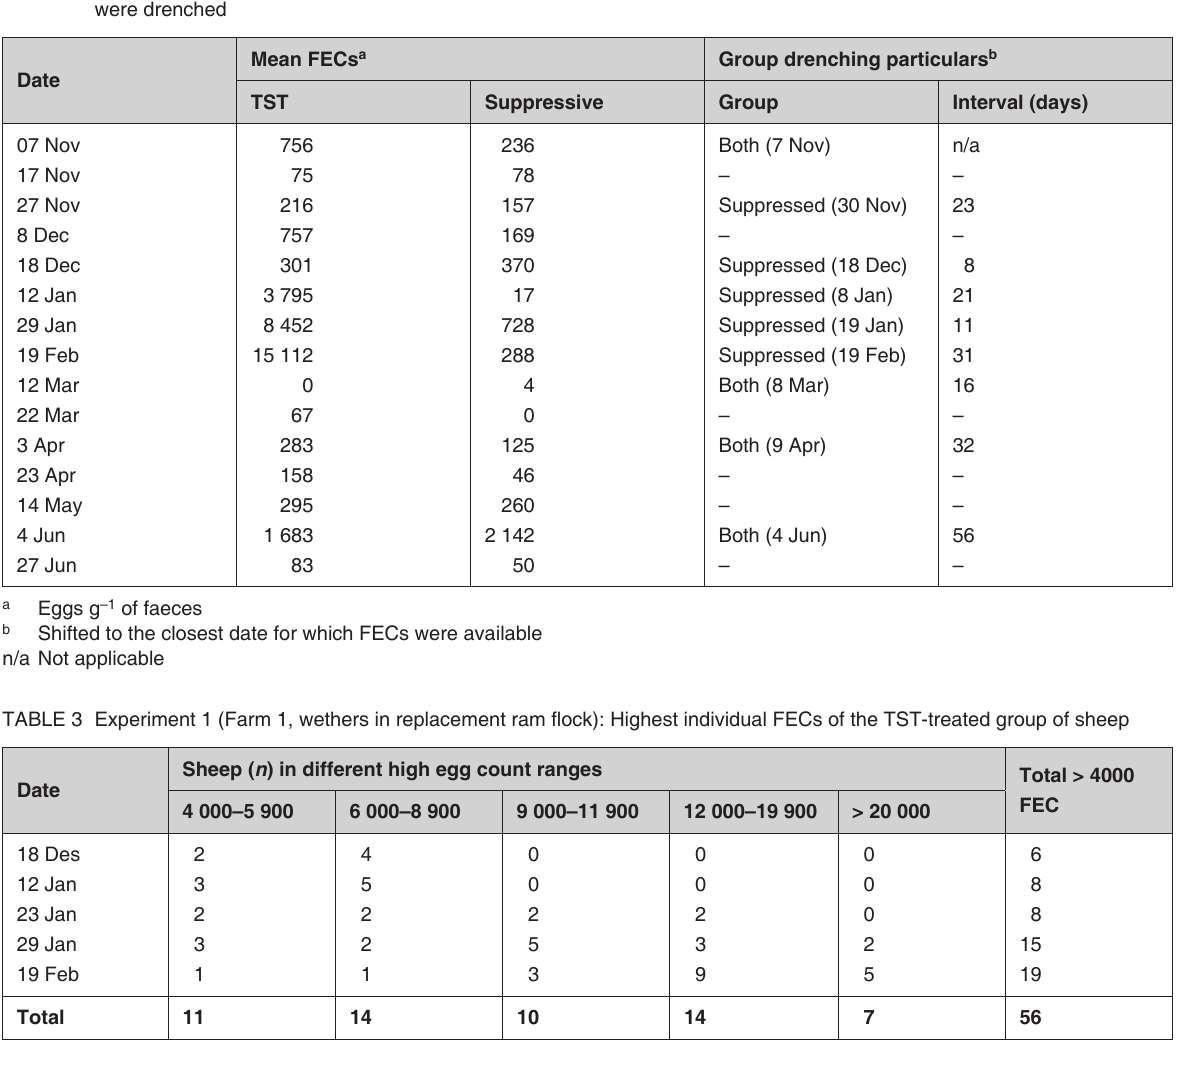
TABLE 4 Farm 1: Anthelmintic restistance reversion using the principle of genetic dilution (Van Wyk & Van Schalkwyk 1990)